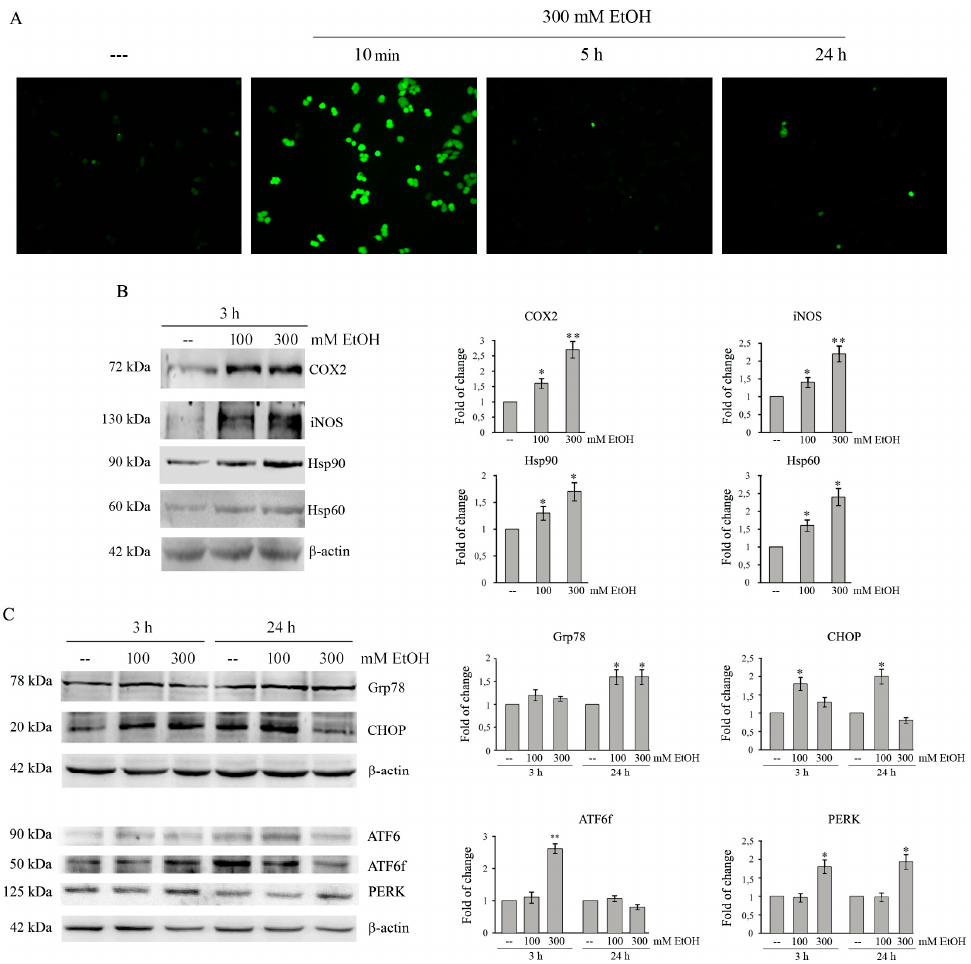
Figure 2. Ethanol induces oxidative and ER stress in colon cancer cells. ( A ) HCT116 cells (7 × 10 3 ) were treated with 300 mM EtOH for the indicated times. Reactive oxygen species (ROS) production was assayed by H2DCFDA staining. Images were taken by a Leica DC300F microscope (200 × original magnification) using a FITC filter. Results are representative of three independent experiments. ( B , C ) Cells (1 × 10 5 ) were treated with 100 or 300 mMEtOH for the indicated times. Cell lysates (30 µ g) were analyzed by Western blotting for COX2, iNOS, Hsp90, and Hsp60 ( B ) or Grp78, CHOP, ATF6 and its fragmented form (ATF6f) and PERK ( C ). Densitometric analysis of bands was carried out as reported in Material and Methods and data were normalized to β -actin expression. Results are from three independent experiments and statistical significance was determined using one-way ANOVA followed by Bonferroni’s test. (*) p < 0.05 and (**) p < 0.01 compared to the untreated